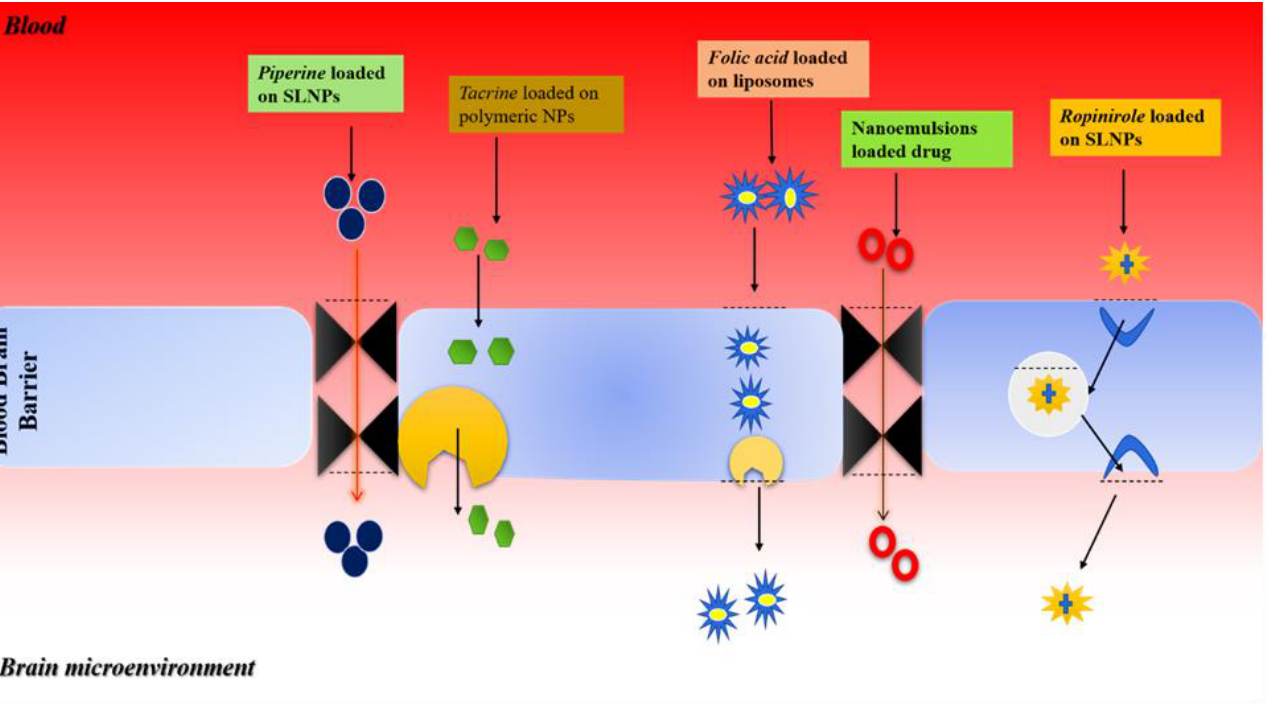
Figure 3. Diagram showing the mechanism of targeted drug delivery across BBB in brain microenvironment. Piperine loaded on SLNPs is injected intraperitonially, across BBB efferently to stop